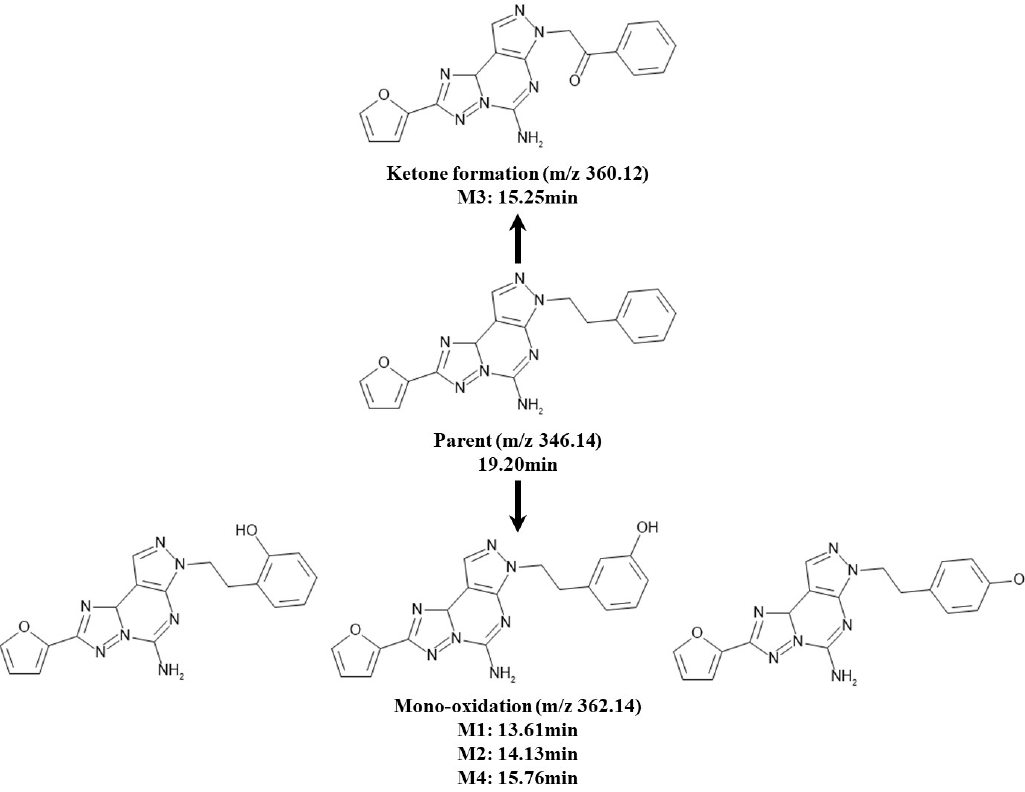
Figure 8. Metabolic pathways and proposed metabolite structures of SCH 58261 in vitro.